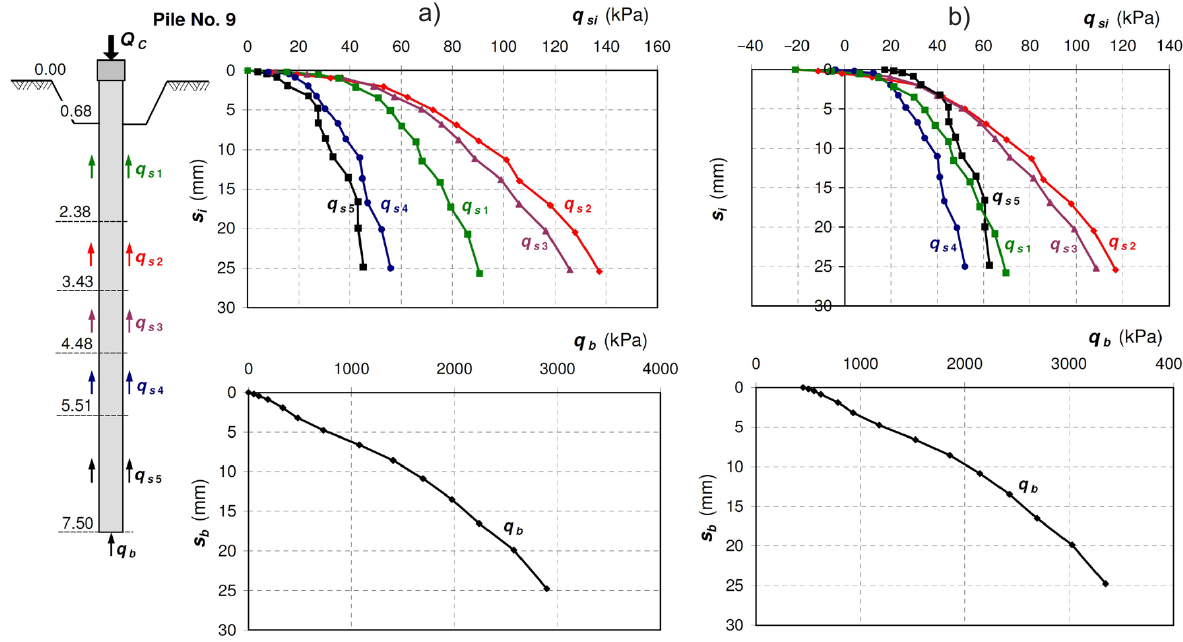
and q unit soil resistances around the pile for the cases: a) without taking into account the residual s b